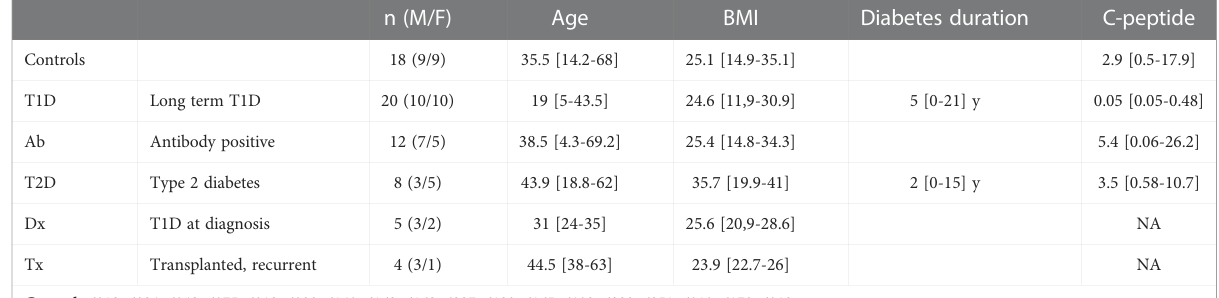
TABLE 1 Characteristics for the investigated patient groups. Below is shown identi fi cation number related to DiViD and nPOD repositories of analyzed samples.